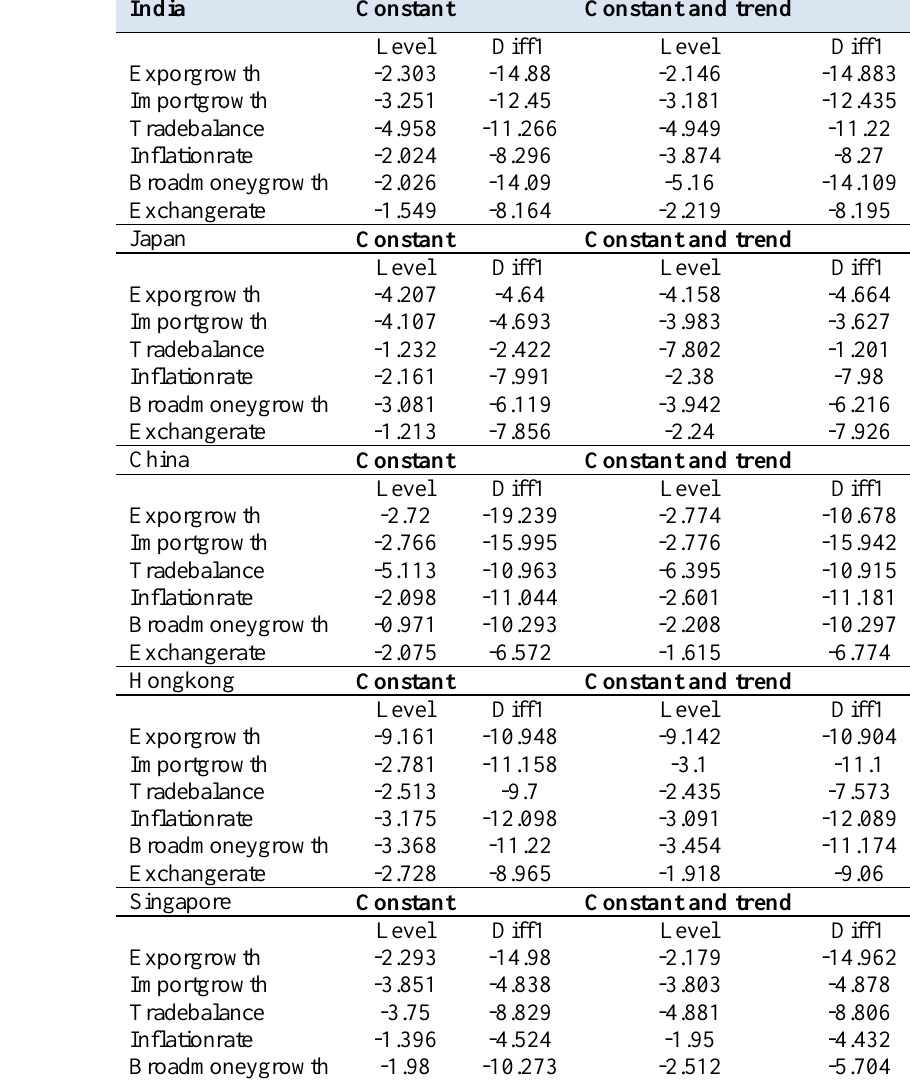
Table 1: Test for Unit Root among the selected macro economic